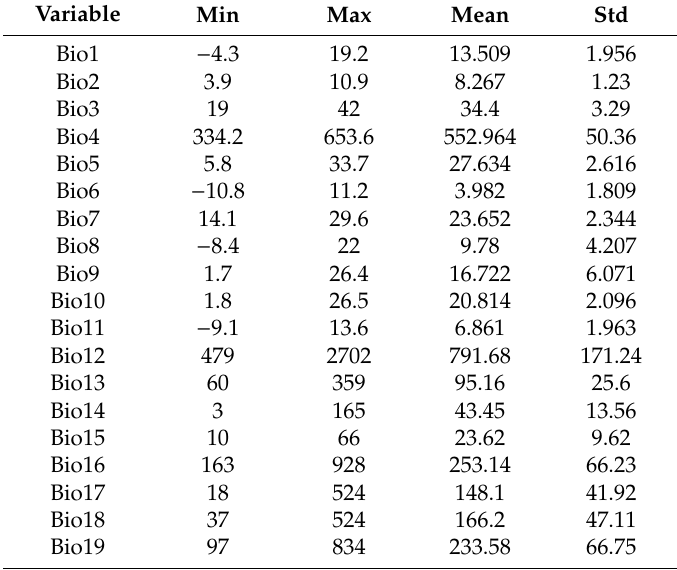
Table A5. 19 Bioclimatic variables of 2070 RCP6.0 scenario (see Figure 1 for variables